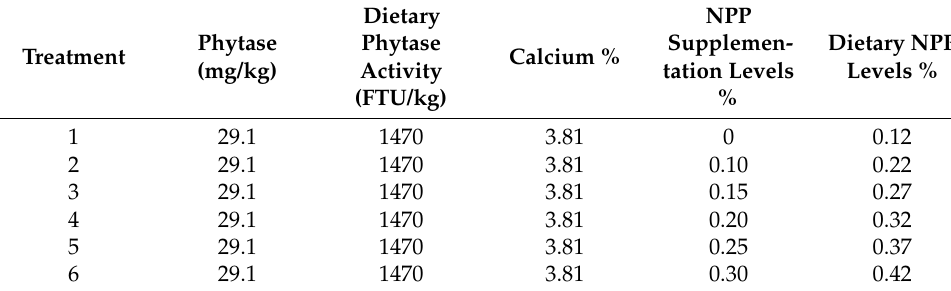
Table 2. Mineral levels and phytase activity of experimental